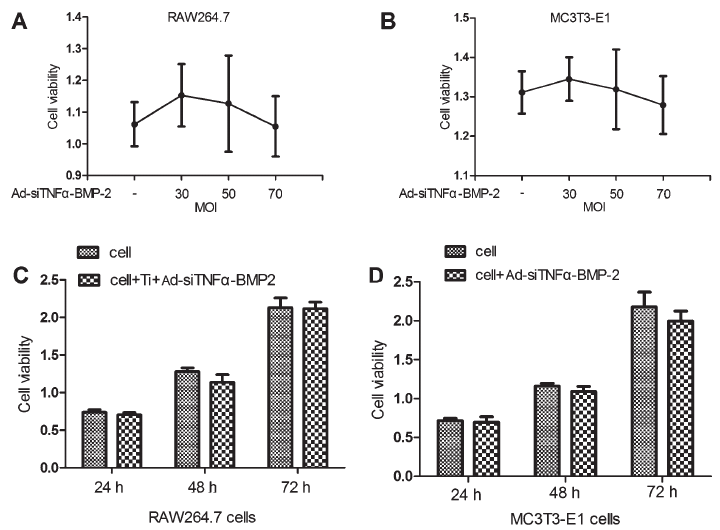
with 0.1 mg/mL Ti particles or a combination of 0.1 mg/ (Figure 2E).